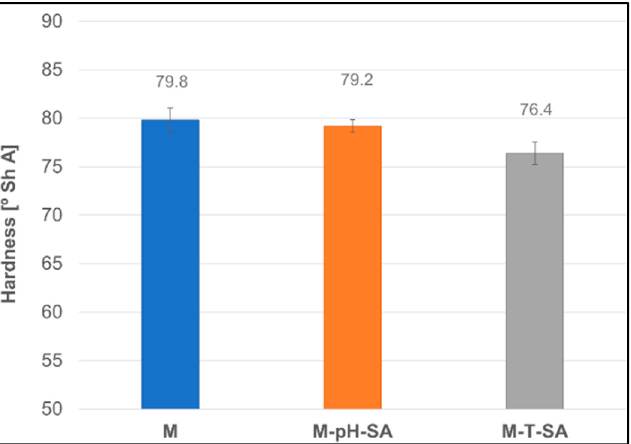
Figure 11. Shore’s A hardness of the bio-hybrid hydrogels ( n = 5).